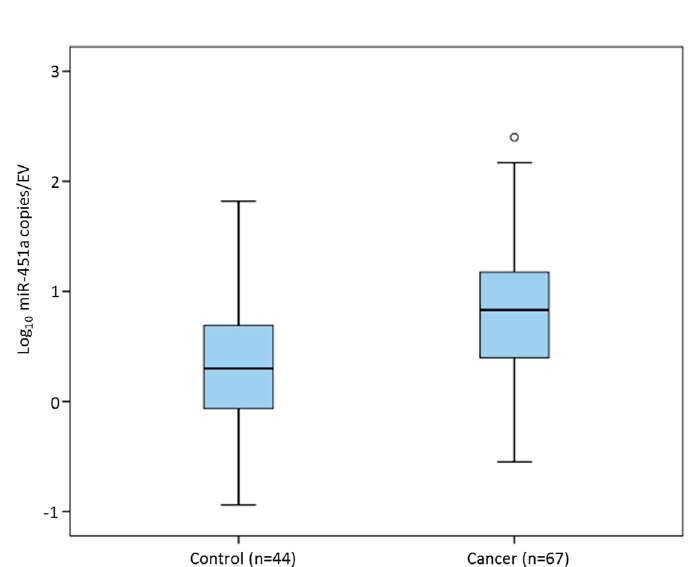
Figure 4. Number of miRNA-451a copies per EV particle in sera of breast cancer patients ( n = 67) compared to healthy control individuals ( n = 44, p = 0.029), o represents outlier